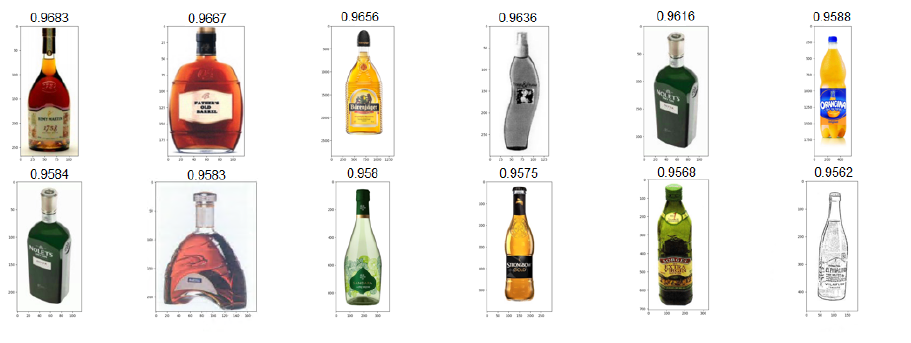
Figure 10. Top-12 result set for input